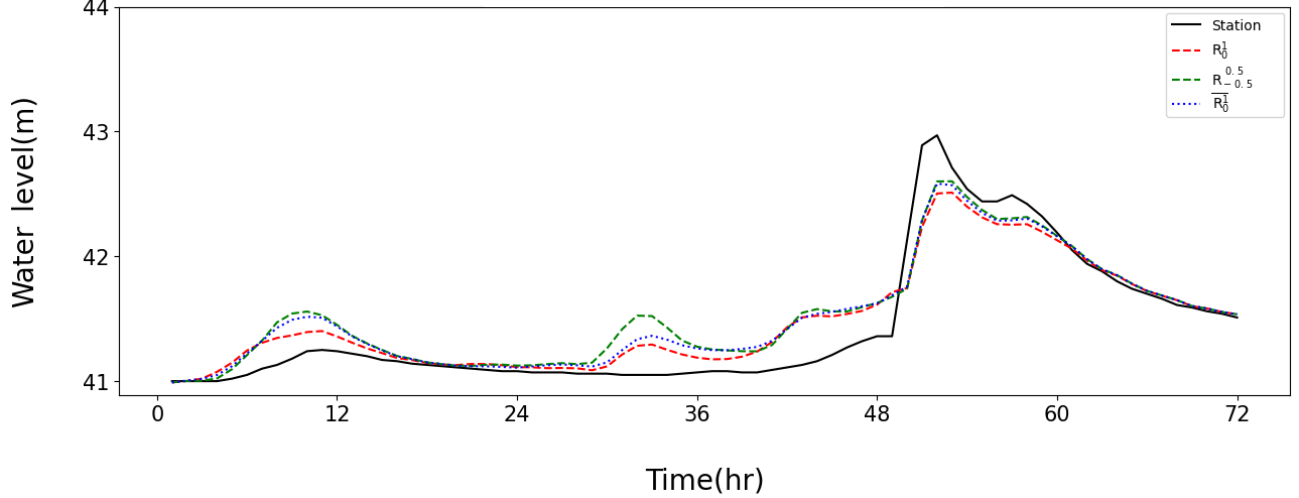
Figure 10. Comparison of simulated water level results for event 1 to event 4 using 𝑅 01 , 𝑅 −0.50.5 , 𝑅 01 rainfall methods.